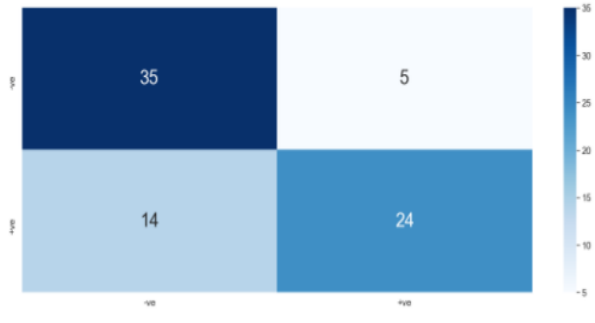
Figure 23. Performance of GBC